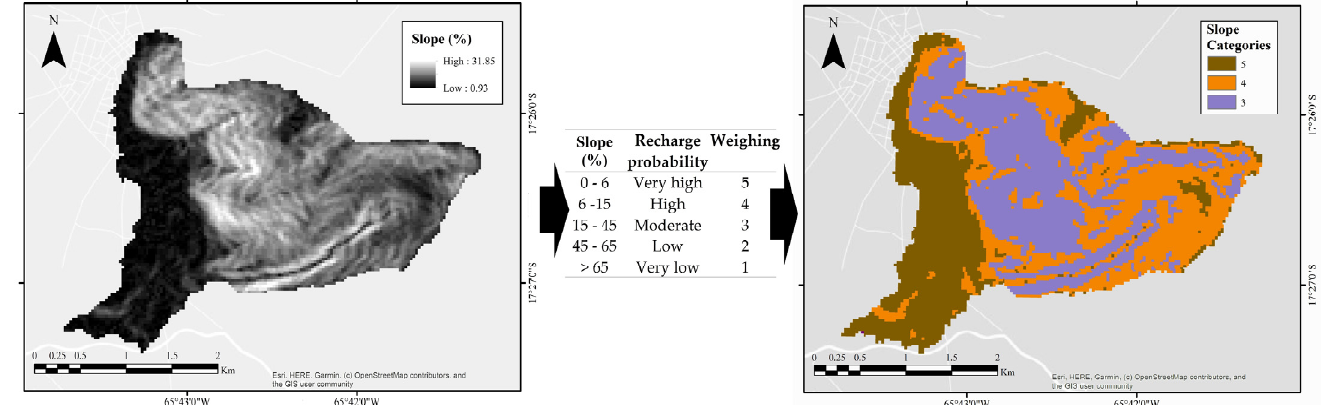
Figure 5. Example of the recategorization process used on each input map to calculate the potential groundwater recharge, according to the evaluation tables proposed by Matus et al. [46]. In this case, the slope map of the Virvini micro-basin is shown to be recategorized.